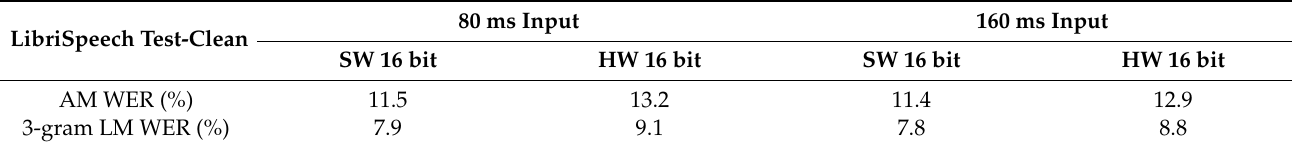
Table 10. Word error rate of proposed ASR system (#weights: 9.3 M).